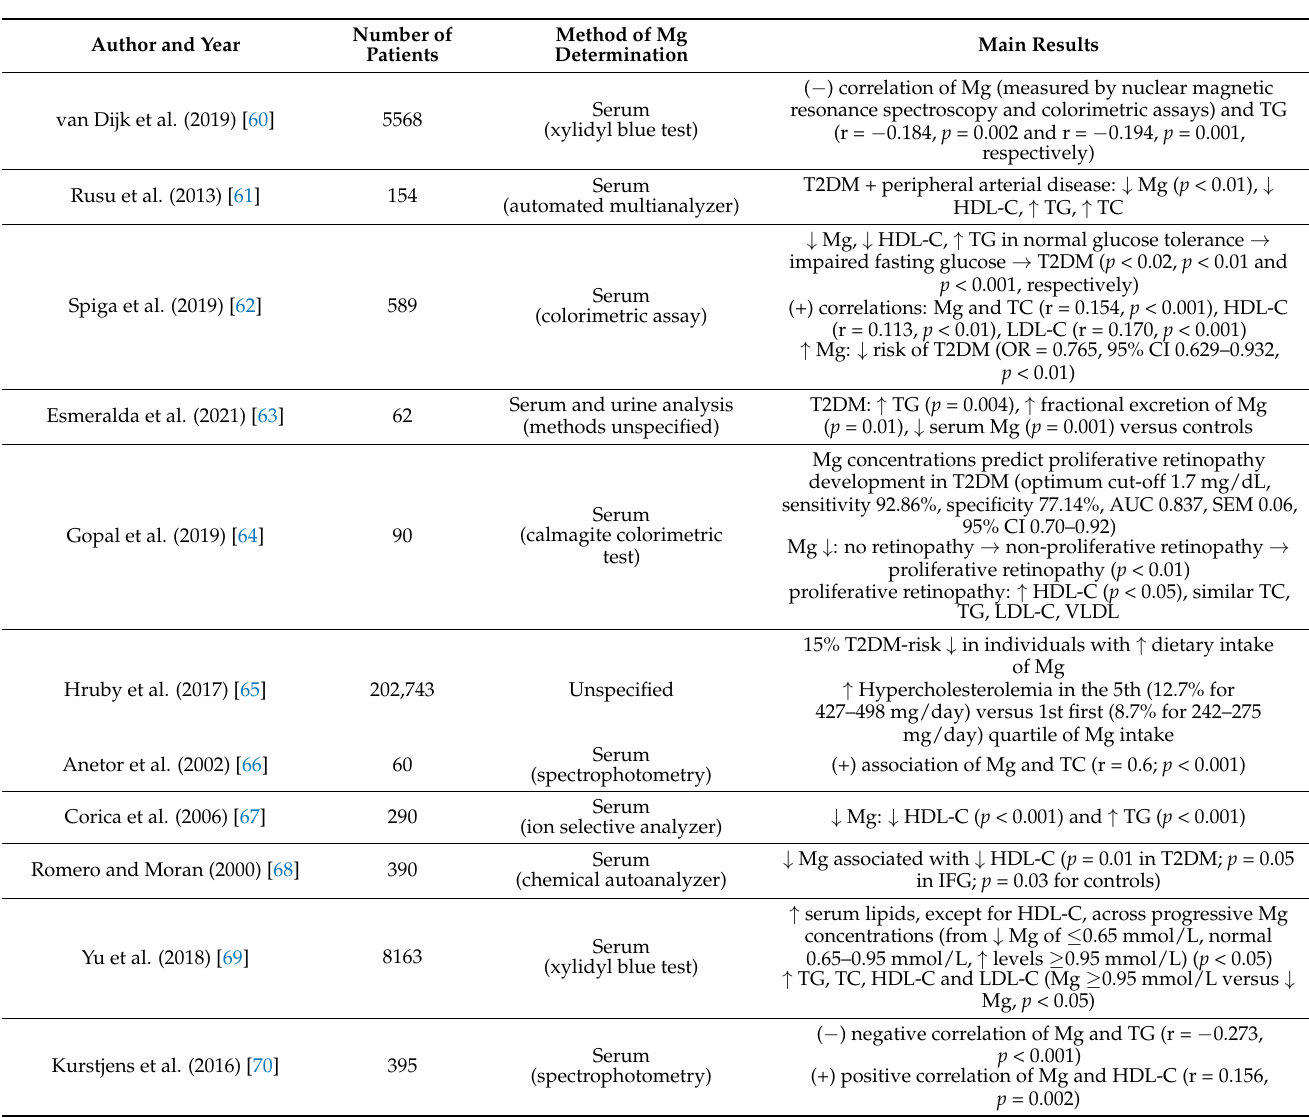
Table 3. Magnesium and serum lipids interplay in